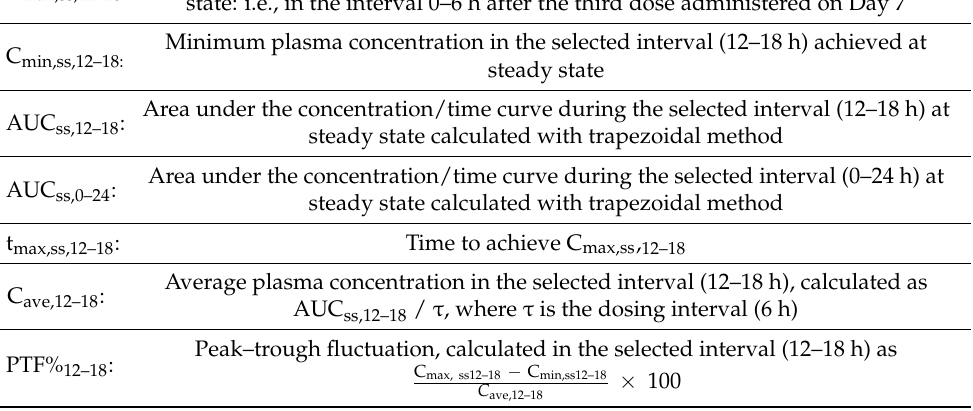
Table 2. Pharmacokinetic parameters planned to be measured and/or calculated for plasma rifamycin SV after multiple doses.